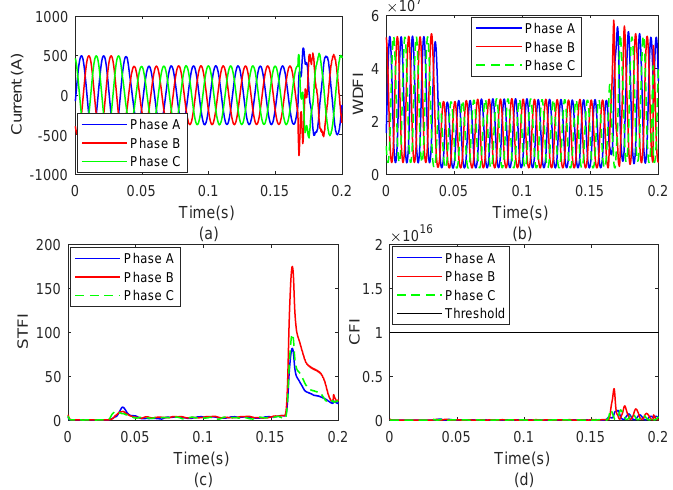
Figure 14. Event of feeder operation ( a ) current waveform ( b ) WDFI ( c ) STFI ( d )